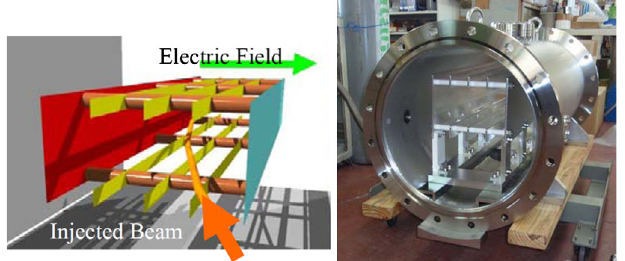
FIG. 16. Schematic view of the injection kicker (left) and a photograph of the kicker (right).